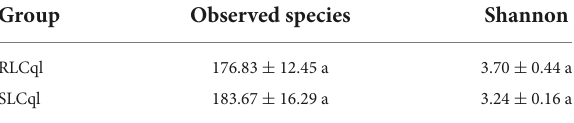
TABLE 3 Alpha diversity indices of gut bacteria from third-instar Culex quinquefasciatus strains that are susceptible and resistant to Lysinibacillus sphaericus C 3 -41.